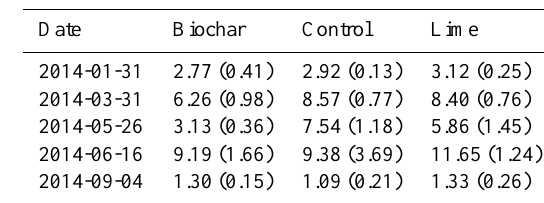
− -Nkg − 1 ) in soil during the ex- Table 1. Nitrate content (mgNO 3 periment. Standard error is indicated in brackets.